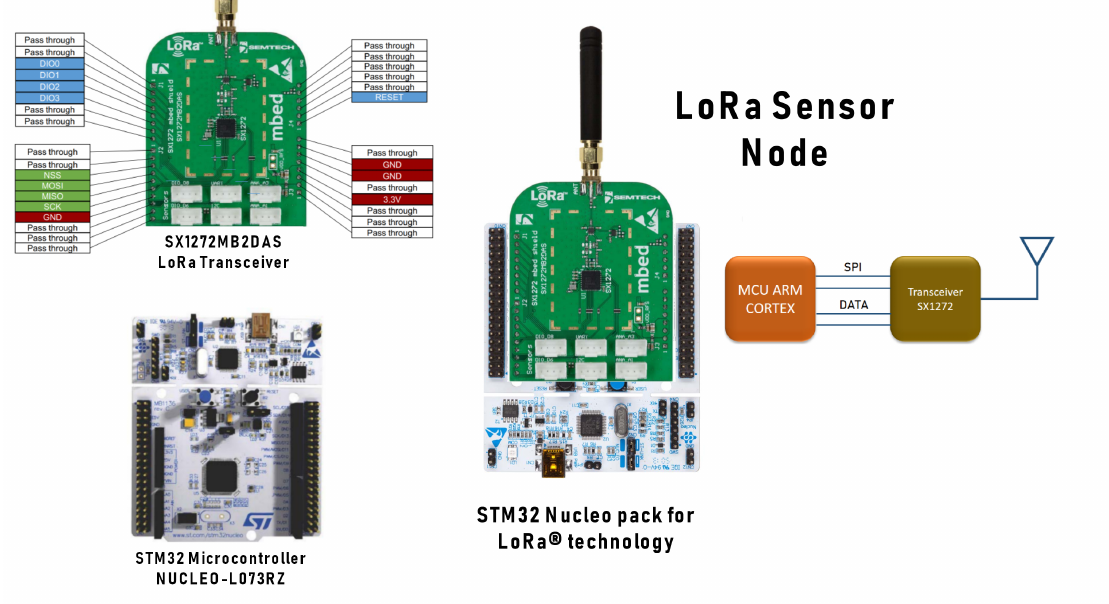
Figure 4. Microcontroller and transceiver of the realized Long Range (LoRa)